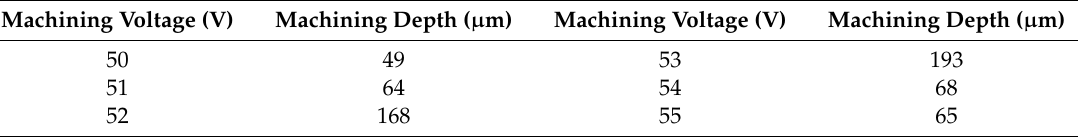
Table 3. Machining depths with the use of combinational machining method under different machining voltages.